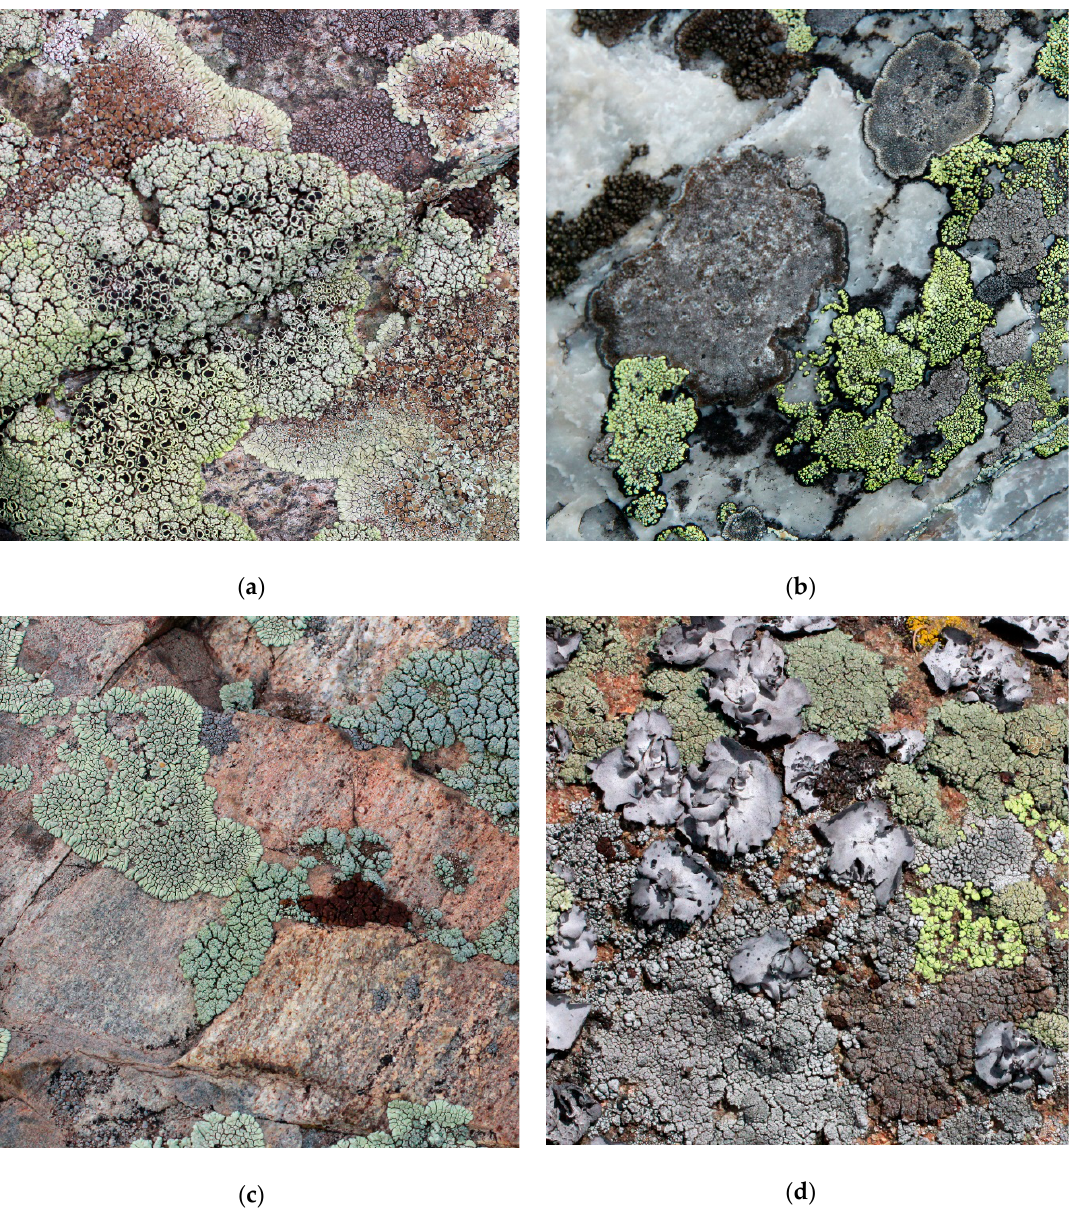
Figure 2. Lichen groupings on three rock types. ( a ) Serpentinite, Akkermanovka settlement, locality 17 ( Lecanora argopholis (Ach.) Ach., Protoparmeliopsis muralis (Schreb.) M.Choisy and Circinaria spp.); ( b ) Quartzite, Zyuratkul’ range, locality 10 ( Rhizocarpon geographicum (L.) DC., Sporastatia testudinea (Ach.) A. Massal. and Protoparmelia badia (Hoffm.) Hafellner); ( c ) Basalt, Khabarnoye settlement, locality 18 ( Dimelaena oreina (Ach.) Norman and Lecanora argopholis ); ( d ) Basalt, Kushai mountain, locality 13 ( Umbilicaria subglabra (Nyl.) Harm., Immersaria athroocarpa (Ach.) Rambold & Pietschm., Aspicilia cinerea (L.) Körb., Lecanora spp.). Bar = 1 cm.